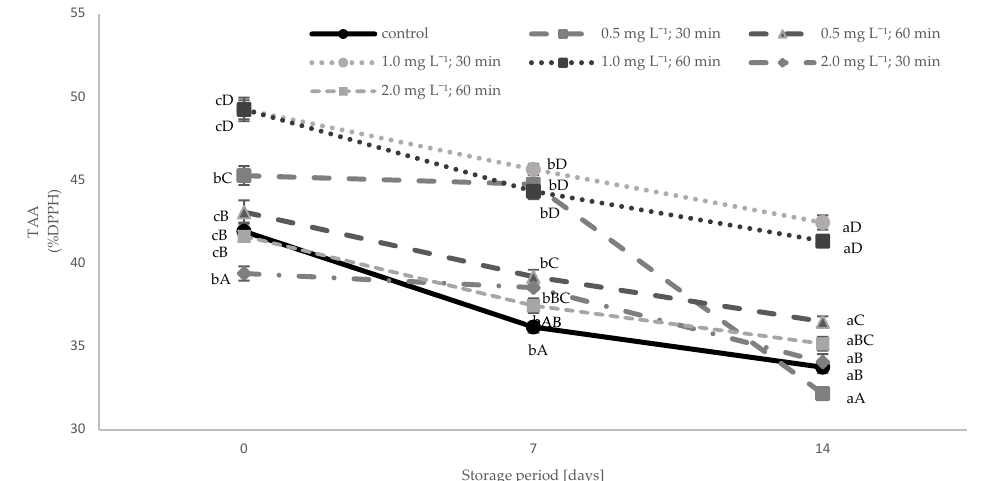
Figure 1. Effect of ozone dose, time of ozonization, and storage time on total phenolic content of Agaricus bisporus measured on 0, 7, and 14 days of storage at 2 °C. a–c: significant statistical differ- ences for each treatment during storage time ( p < 0.05); A–F: significant statistical differences be- tween treatments within each storage time ( p < 0.05). The values represent the mean ± standard error.